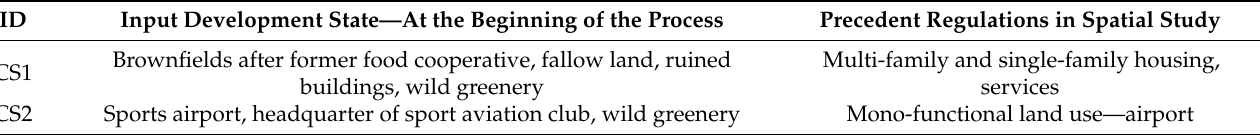
Table 3. Current land use of the analyzed areas and applicable legal